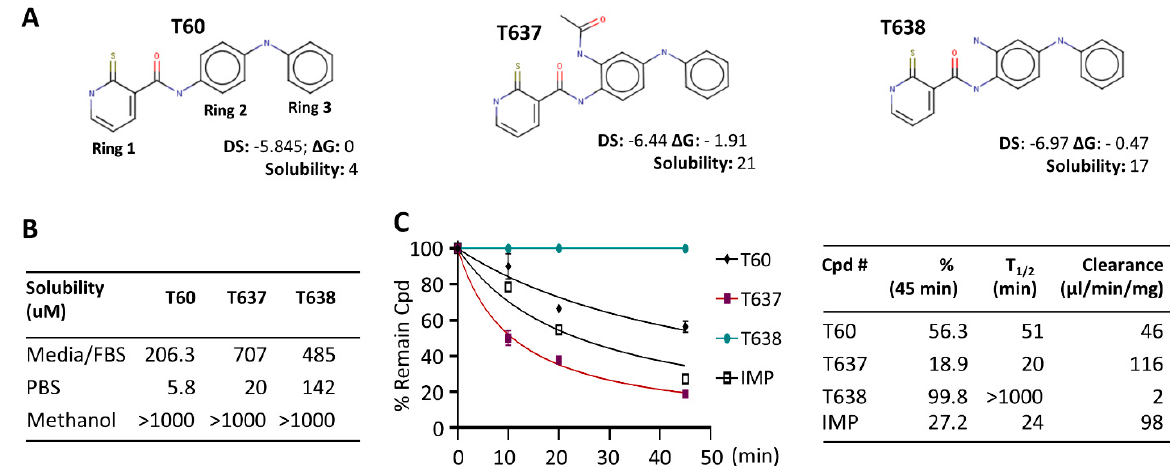
Figure 1. T60 derivatives have improved solubility and metabolic stability. ( A ) The structures of T60, T637, and T638 were designed by CADD. DS, docking score (the lower the better); Δ G, the free energy of binding estimated by FEP+ relative to T60; solubility, an average of three model predictions measured in µM/l; ( B ) The solubility of T60, T637, and T638 in cell culture media with 10% FBS, PBS, and methanol was determined by LC/MS/MS; ( C ) T60, T637, T638 microsomal stability was determined by incubating 1 uM of the compounds with 0.15 mg/mL mouse liver microsomes for 0, 10, 15, 20, and 45 min, with imipramine (IMP) as a positive control. The concentrations of each compound were measured by LC/MS/MS to calculate the clearance rates over the time course.